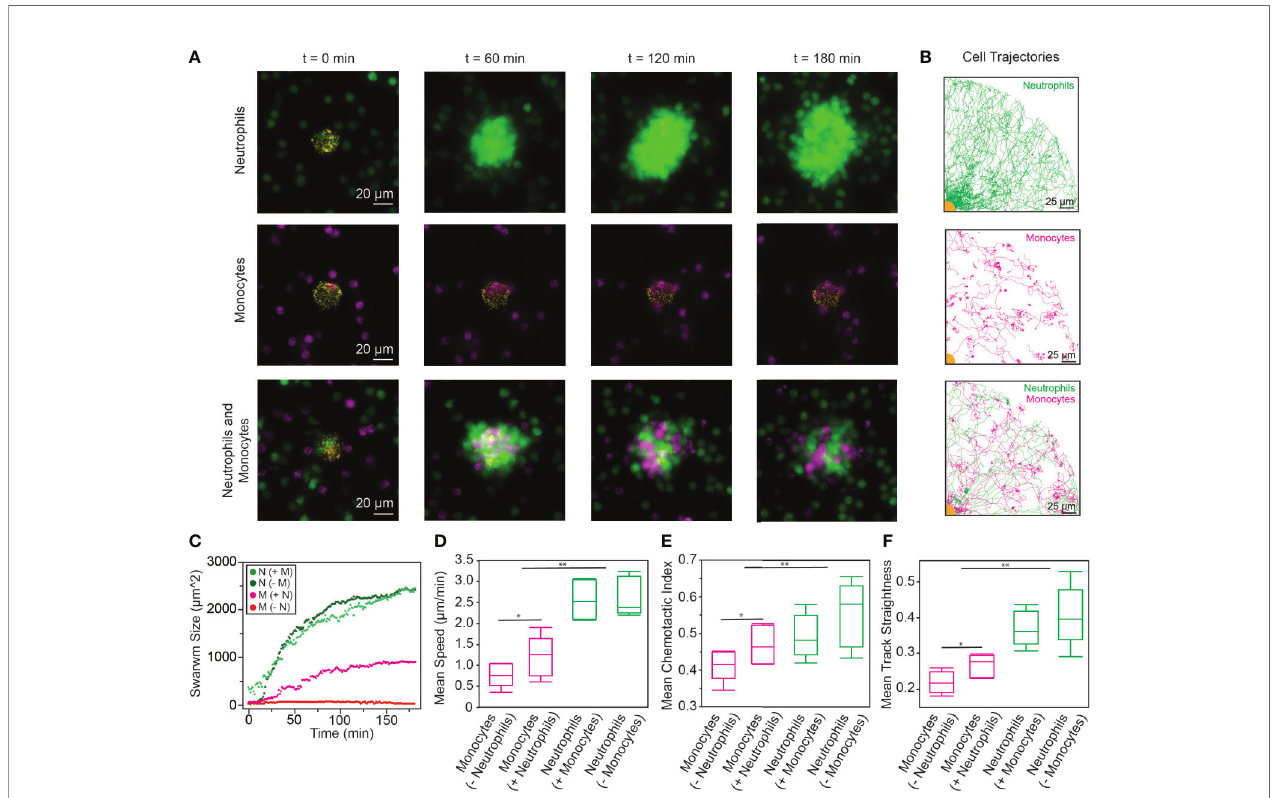
FIGURE 3 | (A) Isolated neutrophils swarmed on the S. aureus bioparticle targets over time (top). However, when monocytes were isolated and added to the targets, no swarming was observed (middle). Interestingly, when neutrophils and monocytes were mixed and added to the bioparticle targets, both neutrophils and monocytes swarmed toward the target (bottom). (scale bars: 20 µm) (B) Neutrophils alone had relatively radial trajectories toward the bioparticle target. Monocytes alone exhibited random migration, with no discernable swarming. When the cells were added in concert, the monocyte trajectories became more radial as the cells were recruited to the swarm. (scale bars: 25 µm) (C) Neutrophils followed similar recruitment patterns to the swarm regardless of the presence of monocytes, measured by 2D swarm size (neutrophils (- monocytes): 2320 ± 590 µm 2 , neutrophils (+ monocytes): 2290 ± 730 µm 2 , p = 0.24, n = 527 each). Monocytes, on the other hand, exhibited dramatically increased recruitment to the swarm in the presence of neutrophils (monocytes (- neutrophils): 8 ± 41 µm 2 , monocytes (+ neutrophils): 870 ± 530 µm 2 , n = 527, p < 0.0001). Monocyte accumulation was lower than neutrophil accumulation in each condition (p < 0.0001). (D – F) . Monocytes exhibited increased speed, CI, and track straightness in the presence of neutrophils (Statistical test: *p < 0.05, student t-test between monocytes (- neutrophils) and monocytes (+ neutrophils), N = 4). There was no signi fi cant difference between the speed, CI, or track straightness of neutrophils in the presence of monocytes and neutrophils alone ( a = 0.05, student t-test between neutrophils (- monocytes) and neutrophils (+ monocytes), N = 4). Additionally, neutrophils exhibited higher speed, CI, and track straightness than monocytes [Statistical test: **p < 0.05, student t-test between all monocyte data (+/- neutrophils) and all neutrophil data (+/-